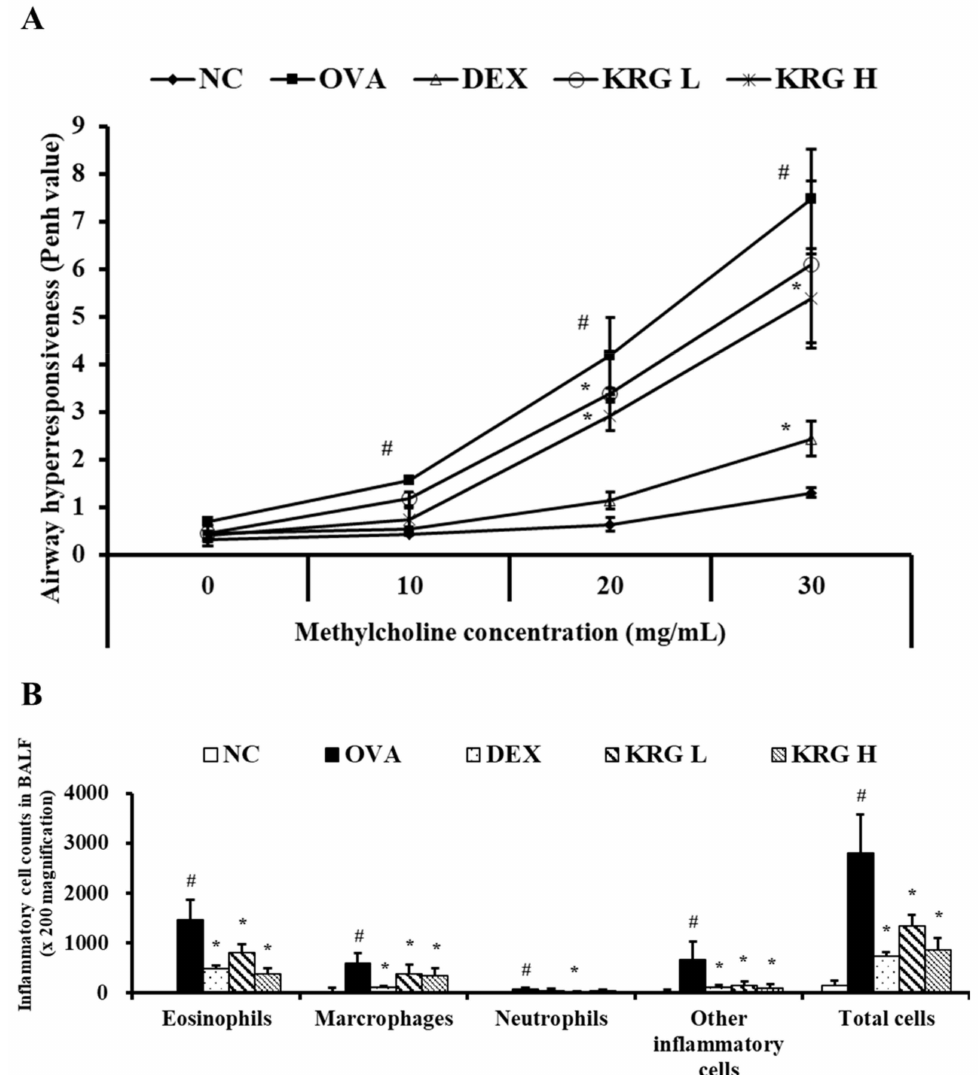
Figure 2. Korean red ginseng (KRG) decreases the elevated ( A ) airway hyperresponsiveness and the ( B ) inflammatory cell count in bronchoalveolar lavage fluid (BALF). Normal control (NC) group; mice administered with the vehicle, ovalbumin (OVA), group; mice treated with OVA and administered with the vehicle, dexamethasone (DEX), group; mice treated with OVA and administered with dexamethasone (3 mg/kg); KRG low (KRG L) and high (KRG H) groups; mice treated with OVA and administered with KRG (100 and 300 mg/kg, respectively). Values: means ± standard deviation ( n = 6). Significance: # p < 0.05 vs. NC; * p < 0.05 vs.